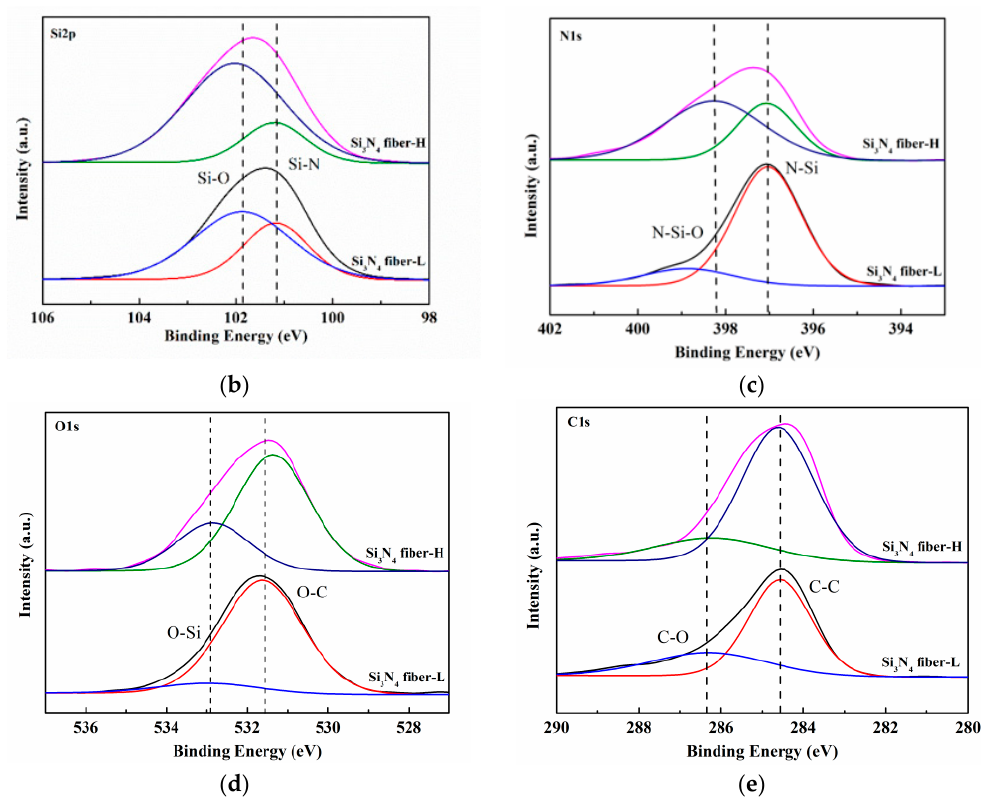
Figure 4. ( a ) XPS survey spectra, ( b ) Si 2p, ( c ) N 1s, ( d ) O 1s, and ( e ) C 1s core level spectra recorded from two desized fibers.